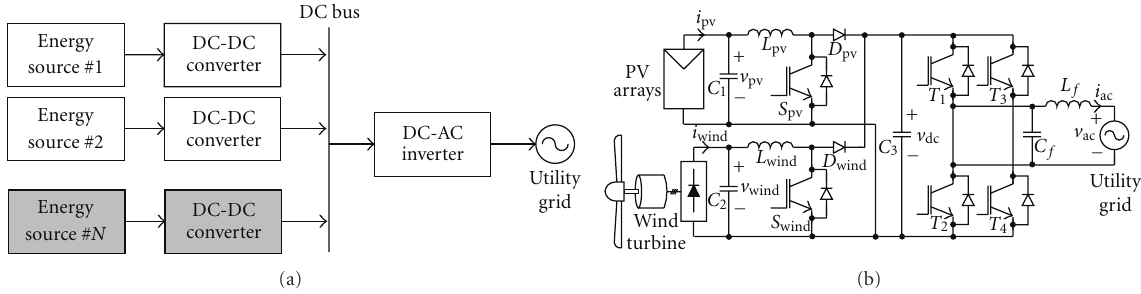
Figure 1: Hybrid PV/wind generation system—(a) general structure of typical hybrid system and (b) hybrid system based on VSI topology. i pv